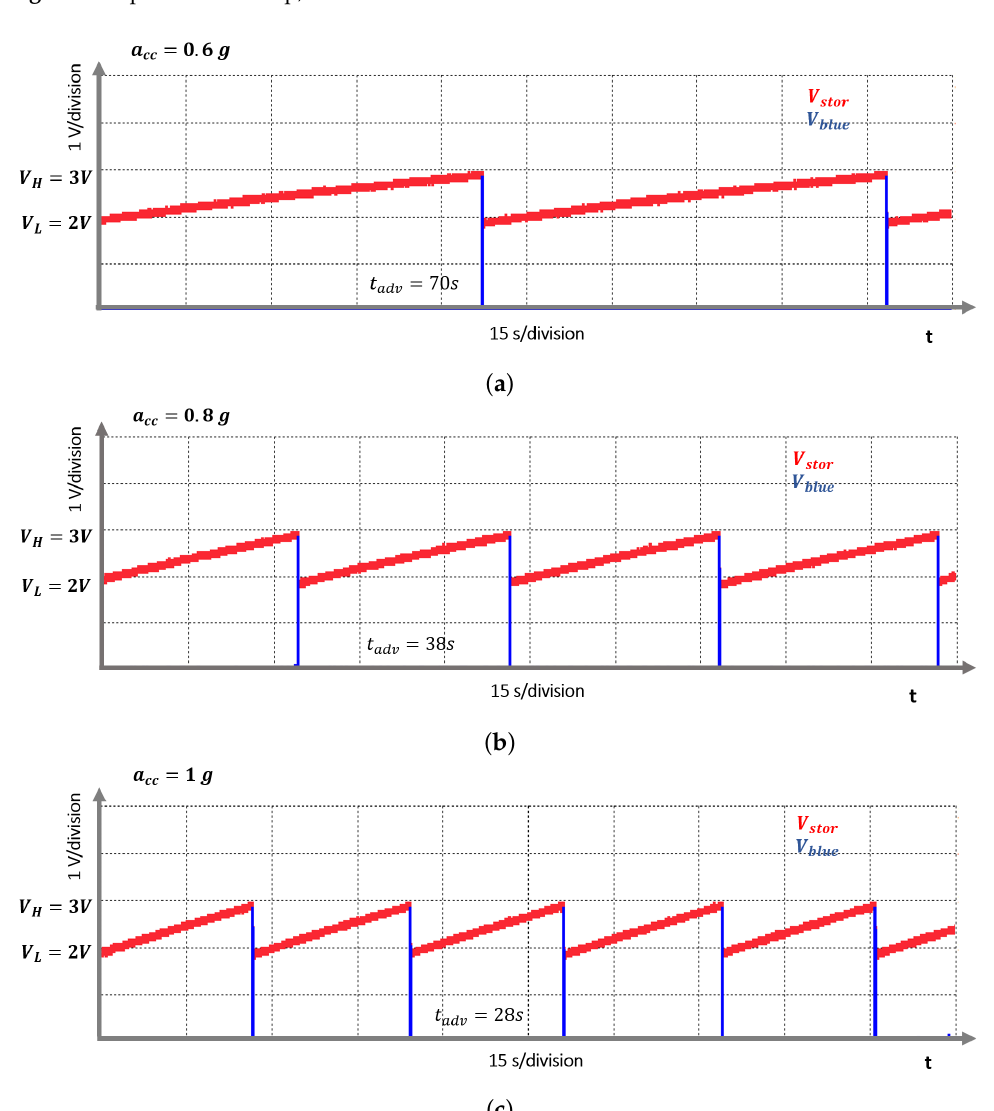
Figure 8. V stor and V blue vs. time at three different accelerations: ( a ) a cc =0.6g, ( b ) a cc =0.8g